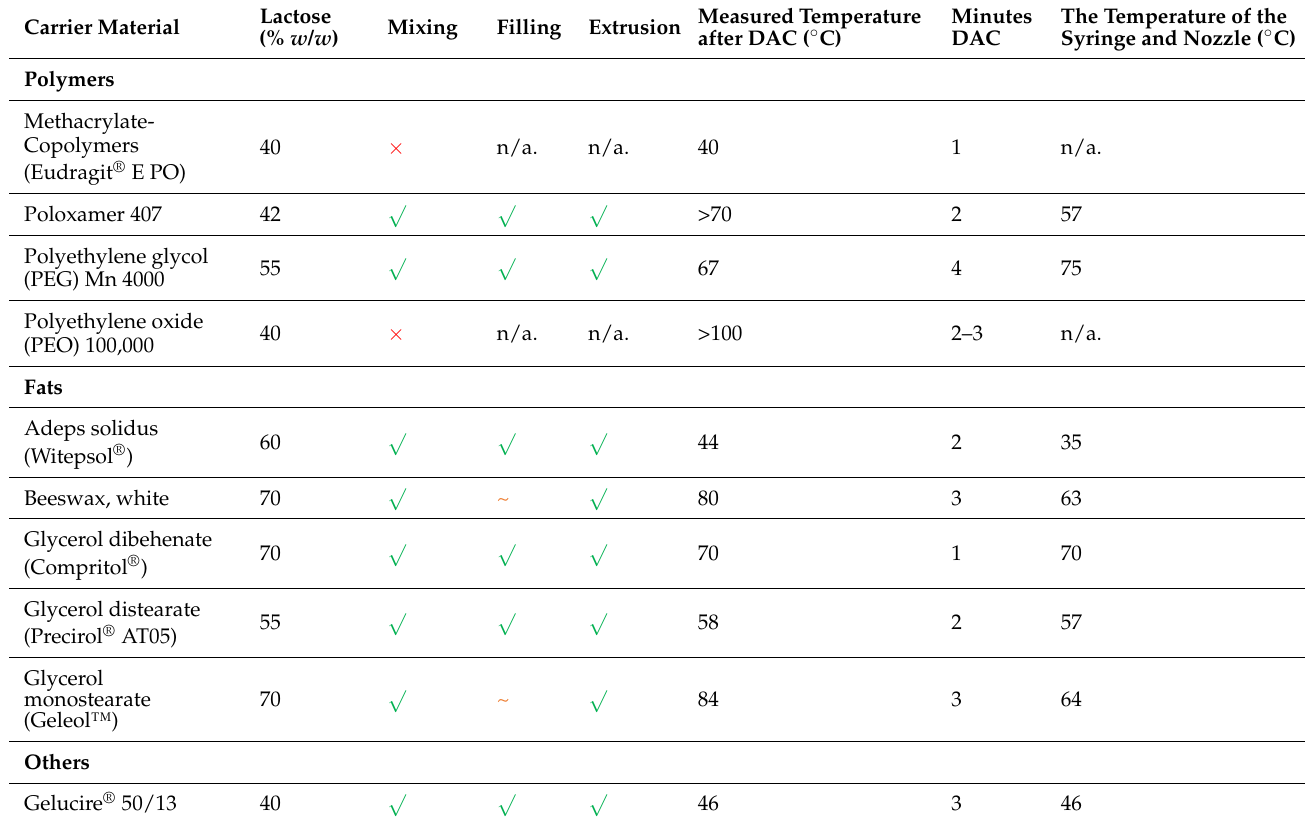
Table 2. Outcomes of extrudability screening per formulation of carrier material and lactose. ( green means successful, ~ in orange means suboptimal and a red × means unable to